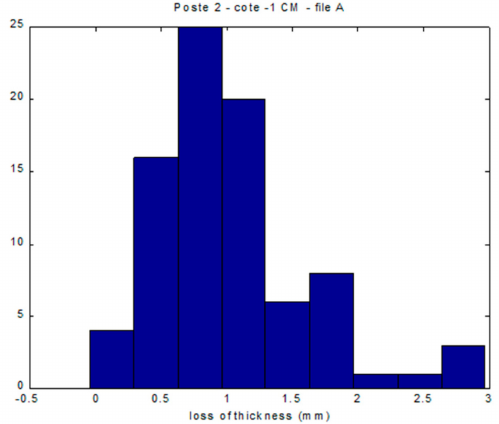
Figure 12. Distribution of the LoT after 25 years, in the Low Seawater